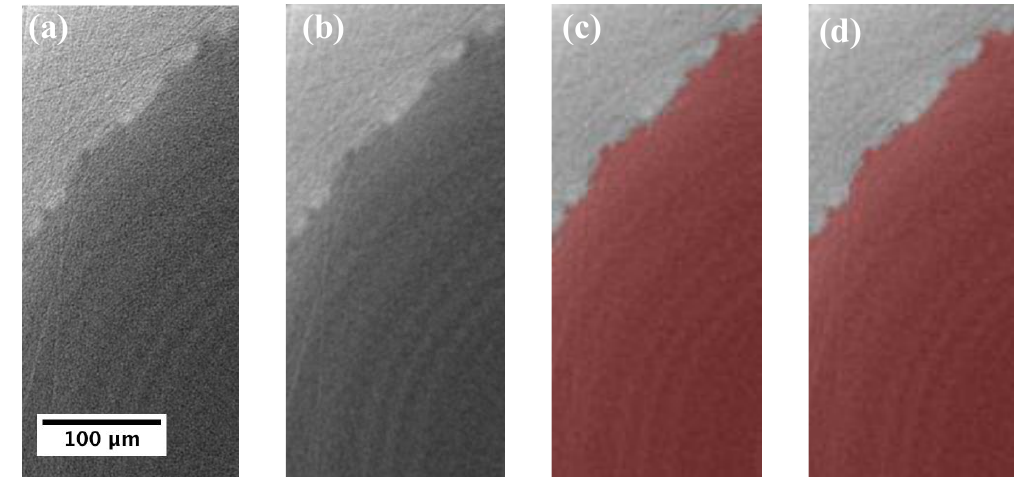
Figure 3. Images showing the filtering and separation processes of the sample and capsule. The images are zoomed in corresponding to the rectangular area in Figure 2c to better show the effects of different processes. ( a ) Reconstructed slice after adjusting contrast and brightness. ( b ) Slice after applying the mean filter. ( c ) Slice showing the separated sample based on specifying the general thresholding range (GTR) and Seed Range (SR). ( d ) Slice showing the separated sample after applying the Remove Islands/Holes filter and the Majority filter.